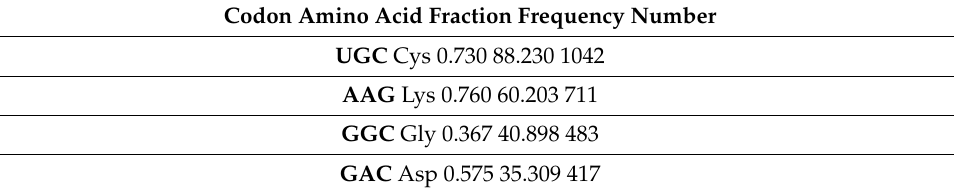
Table 2. 15 most frequently used codons of G. duodenalis highly expressed VSPs